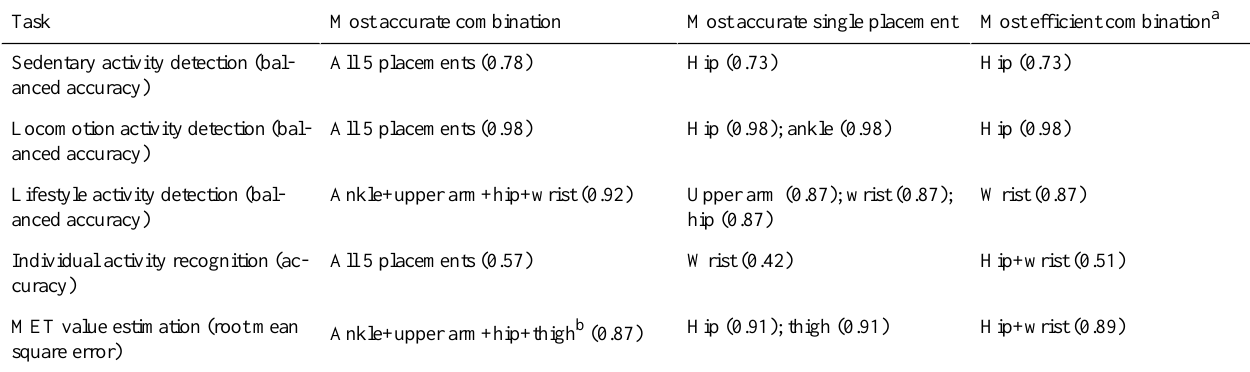
Most efficient combination a Most accurate single placementMost accurate